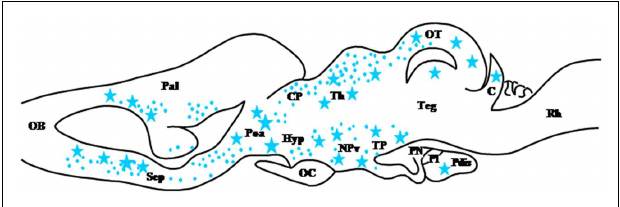
FIGURE 4 | Schematic parasagittal section depicting the distribution of 5 α -reductase (5 α -R)-immunoreactive cell bodies (stars) and fibers (dots) in the developing central nervous system of Rana esculenta at developmental stage XIX–XXV (Bruzzone et al., 2010). For other designations, see Figure 2